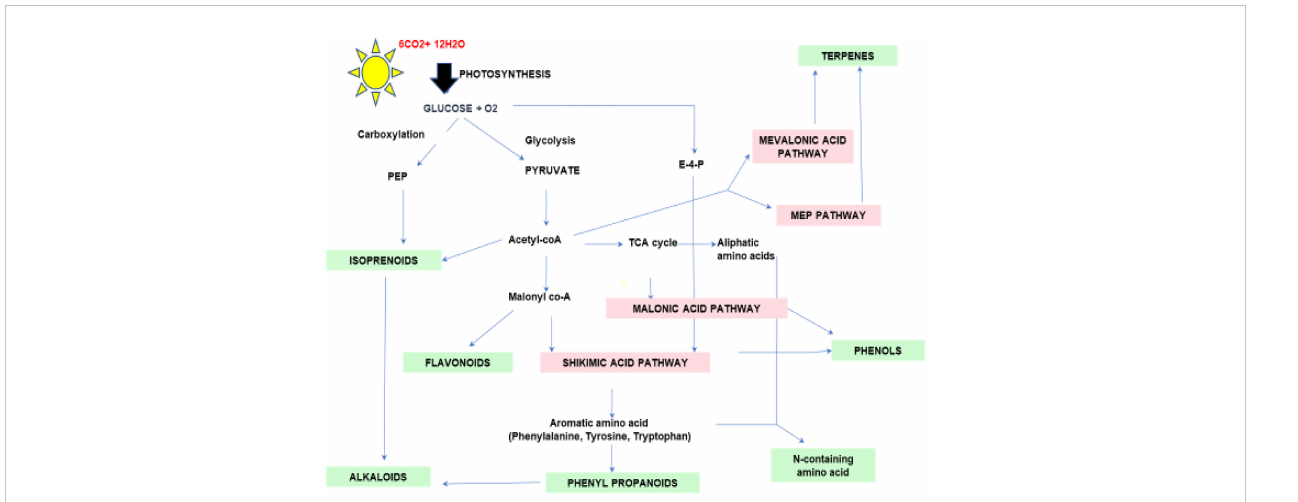
FIGURE 1 Schematic diagram of secondary metabolic biosynthesis pathway. Phosphenol pyruvate (PEP), Erythrose-4-phosphate (E-4-P), and Tricarboxylic acid (TCA)